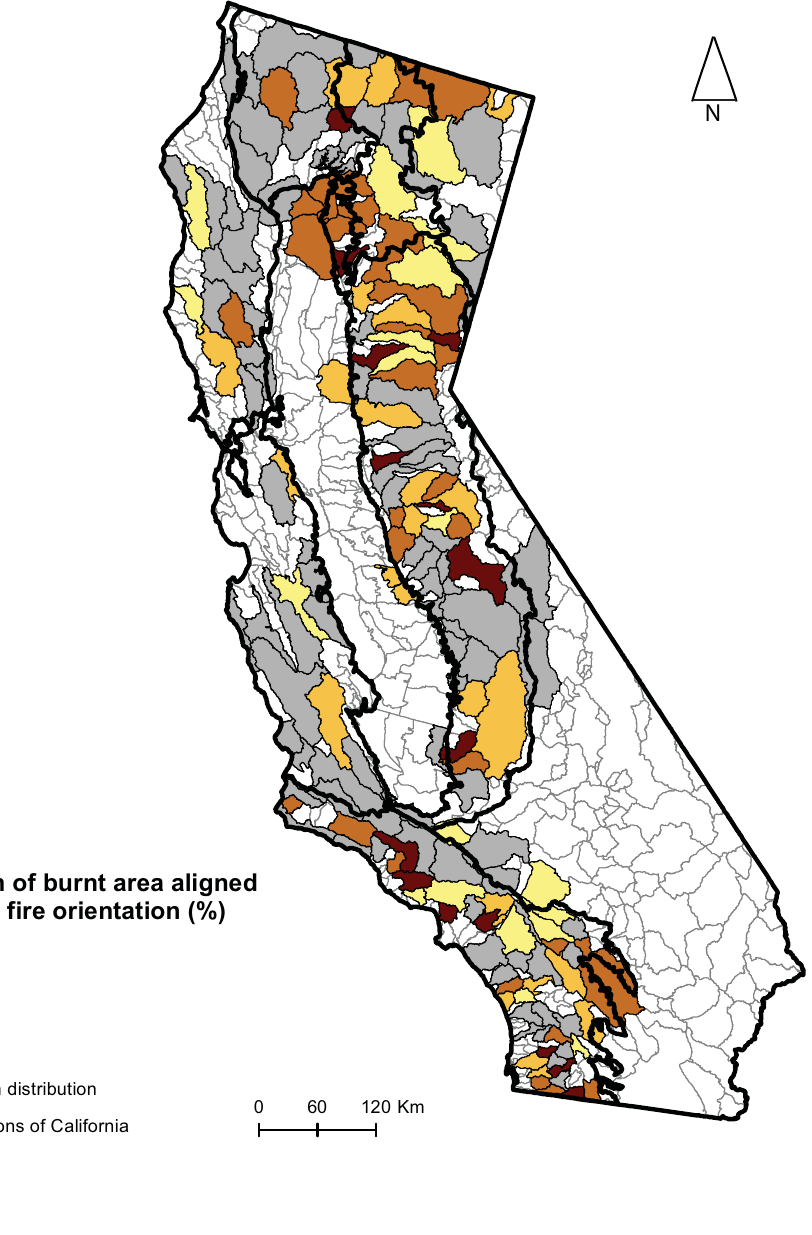
Figure 7. Proportion of burnt area associated with fire perimeters aligned with the mean fire orientation (Figure 5b). In each watershed, a perimeter is considered aligned when its individual orientation is aligned with the mean fire orientation ± 15 ◦